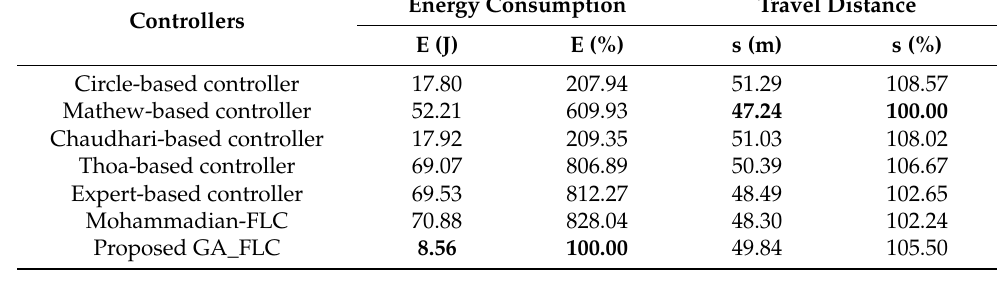
Table 15. Energy consumption and travel distance of the robot when the robot tracks the diamond- shaped path by the different controllers. Bold values are the best in the appropriate column.